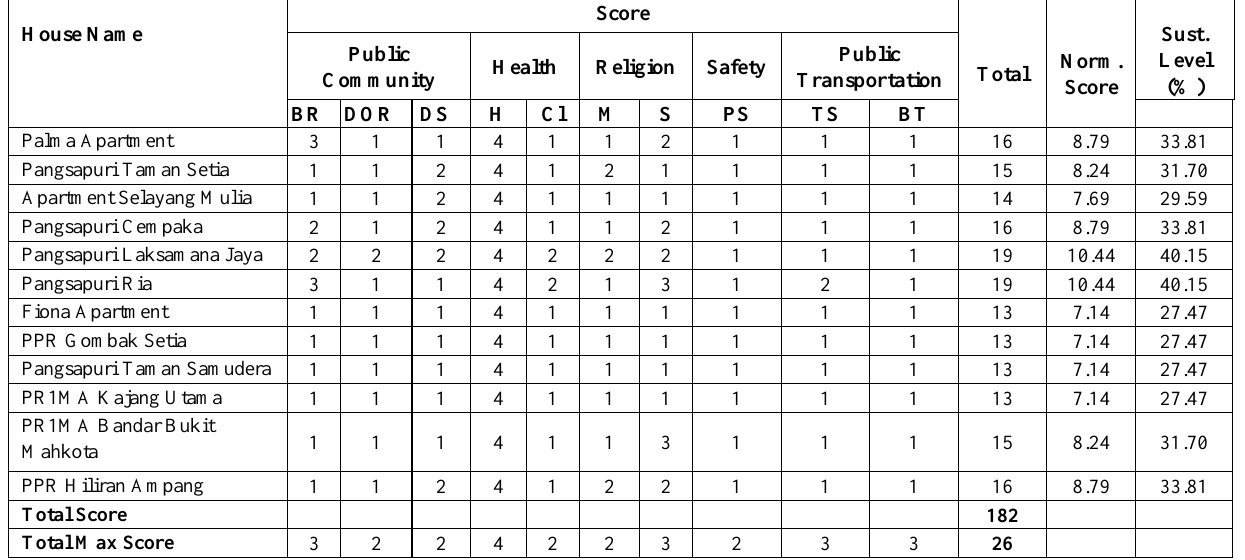
Table 7: The scores obtained for indicators and